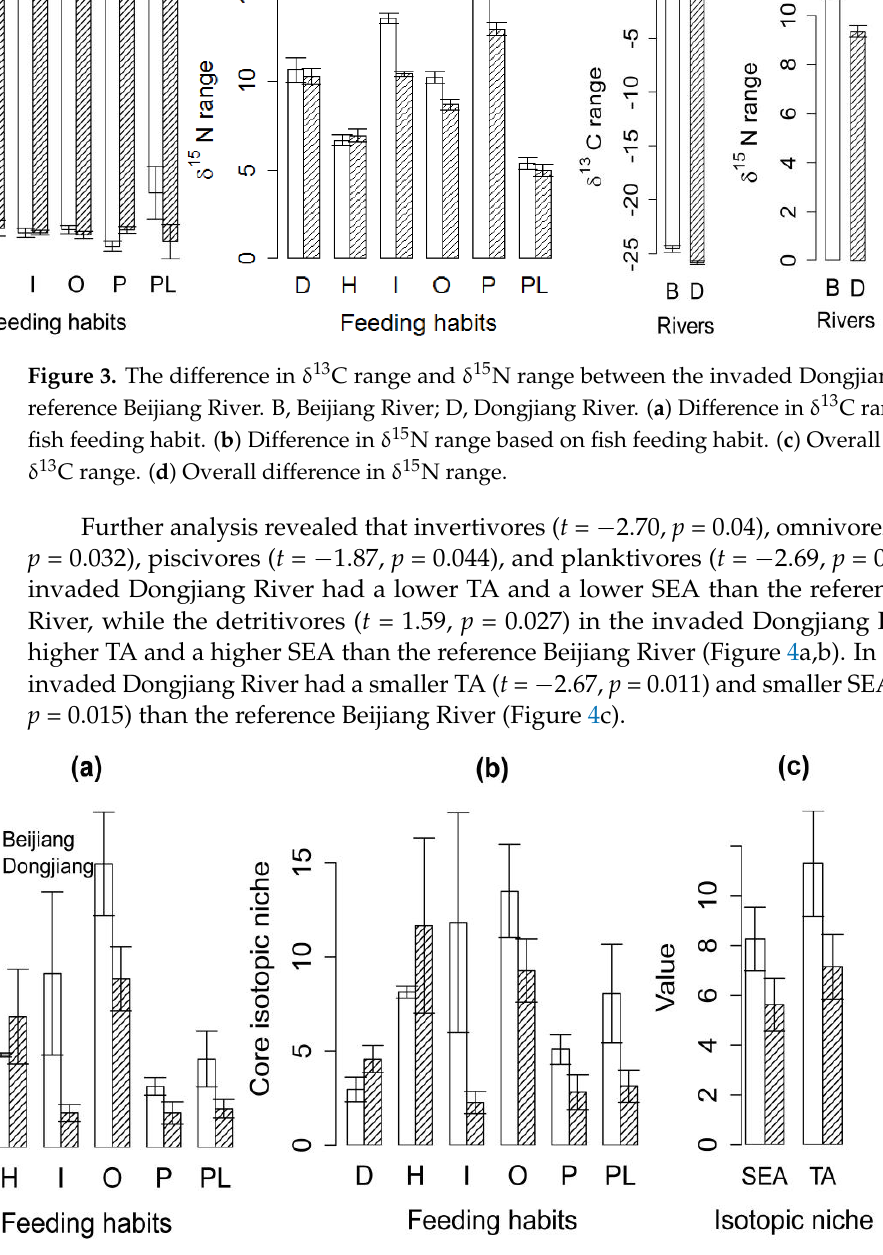
Figure 5. Differences in isotopic diversity index in the invaded Dongjiang River and the reference Beijiang River. IDiv, isotopic divergence; IRic, isotopic richness; IEve, isotopic evenness; IUni, isotopic uniqueness. 4. Discussion Freshwater ecosystems are considered to be among the most altered ecosystems in the world, especially because of the widespread introduction of non-native fish [1]. Introduced fish species have been shown to alter existing biological interactions among native species [3] and modify the overall trophic structure of recipient communities. For instance, introduced predators can increase food chain length [47]. In the current study,